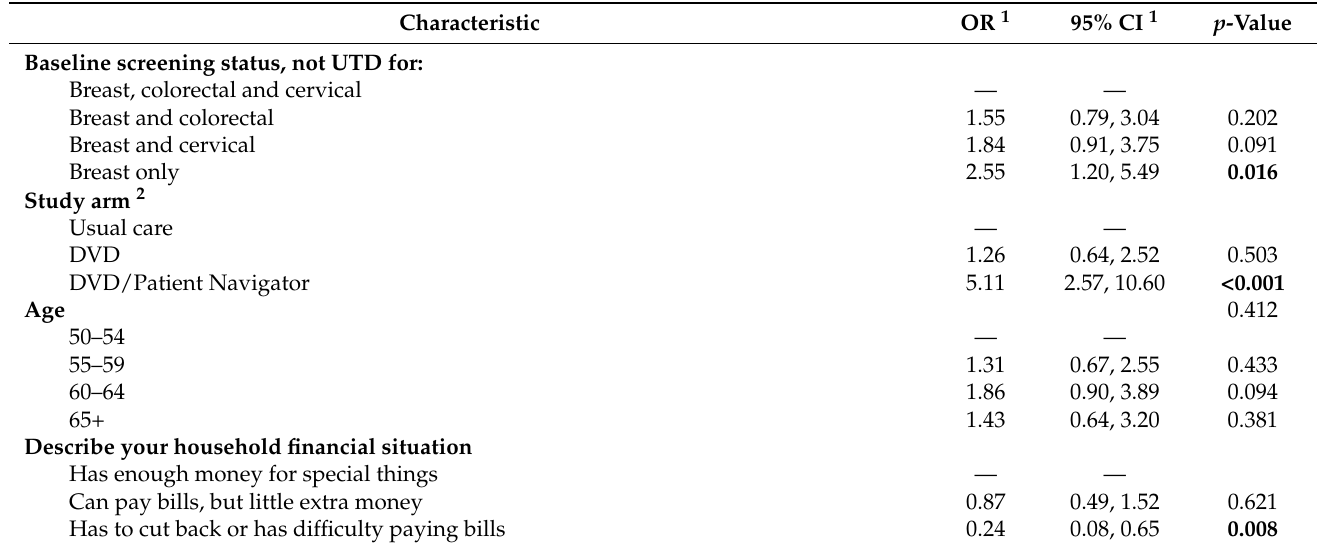
Table 3. Multivariable logistic regression model of being UTD for breast cancer screening at 12 months (N =